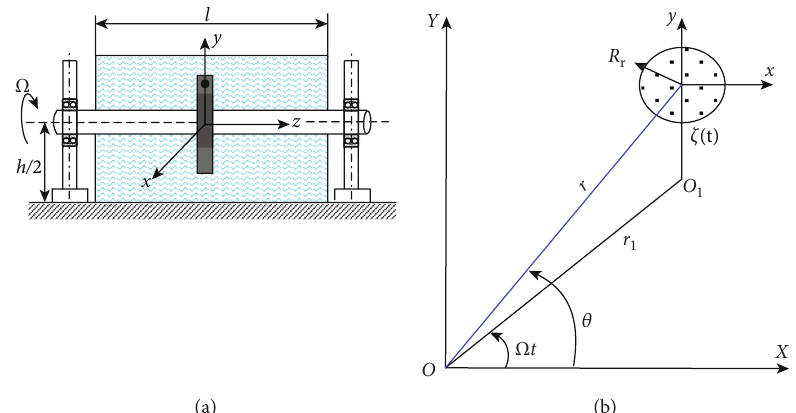
Figure 3: Schematic of a submerged rotor in the inviscid fl uid (a) rotor under lateral excitation and (b) fl uid pro fi